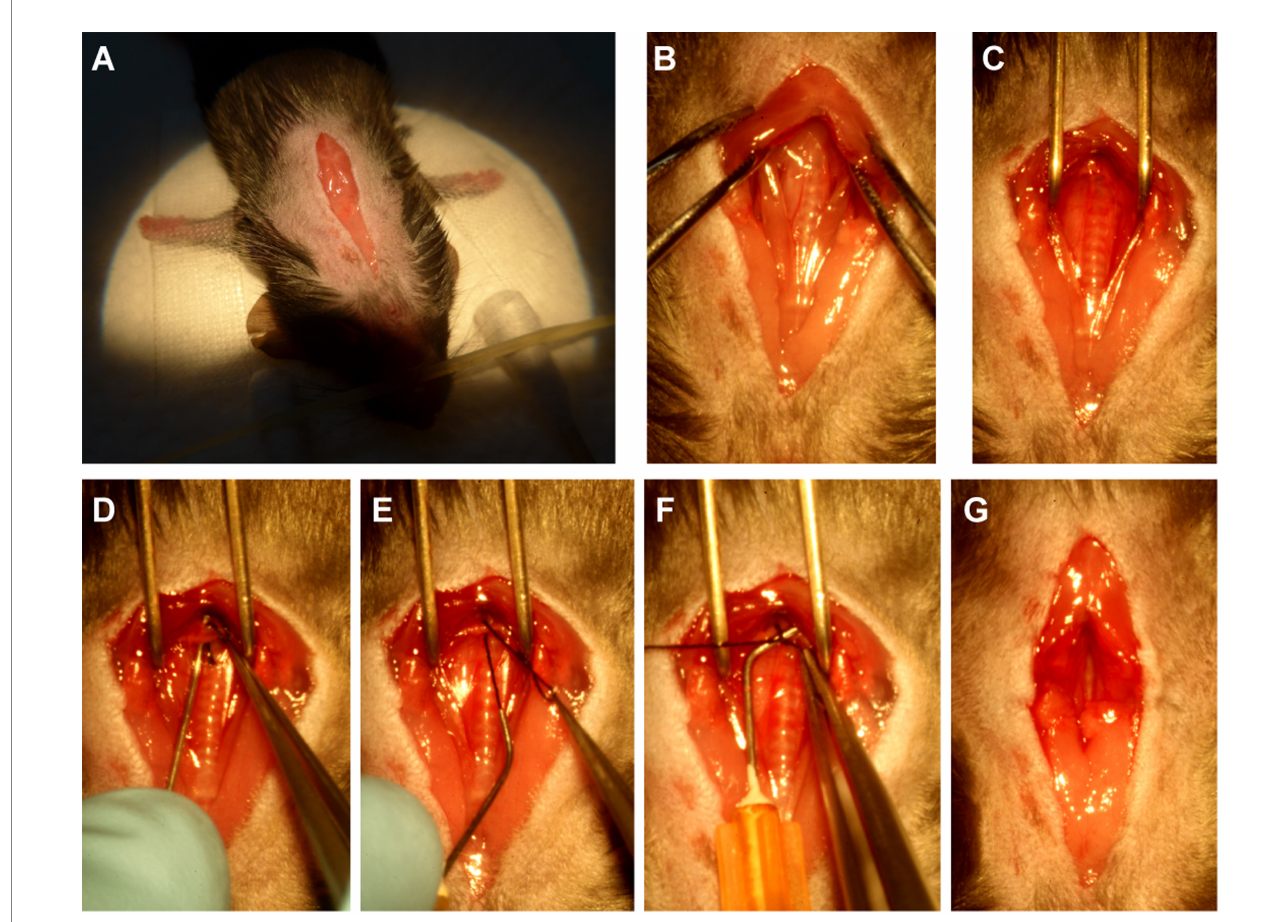
FIGURE 2 The procedure of minimally invasive TAC. (A) Open a 1.5 ~ 2 cm incision at the midline of the neck and chest. (B) Cut the sternum stem about 3~5 mm. (C) Separate the aortic arch from the nearby connective tissue by using the above-mentioned simple surgical retractor. (D) Guide the suture under the aortic arch by using the above-mentioned curved needle with suture. (E) Pull out of the suture from the curved needle. (F) Binding a constriction of the desired diameter with the above-mentioned 25-gauge curved needle. (G) Completed